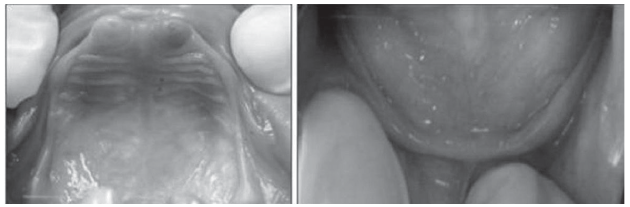
Fig. 5 : Master impressions with aluminum trays.